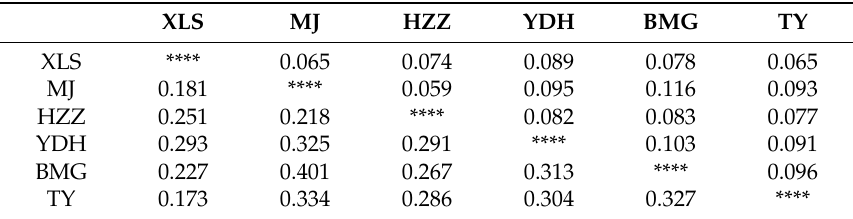
Table 4. Nei’s genetic distance (below asterisks) and pairwise genetic differentiation index (F st ) (above asterisks) among six populations.